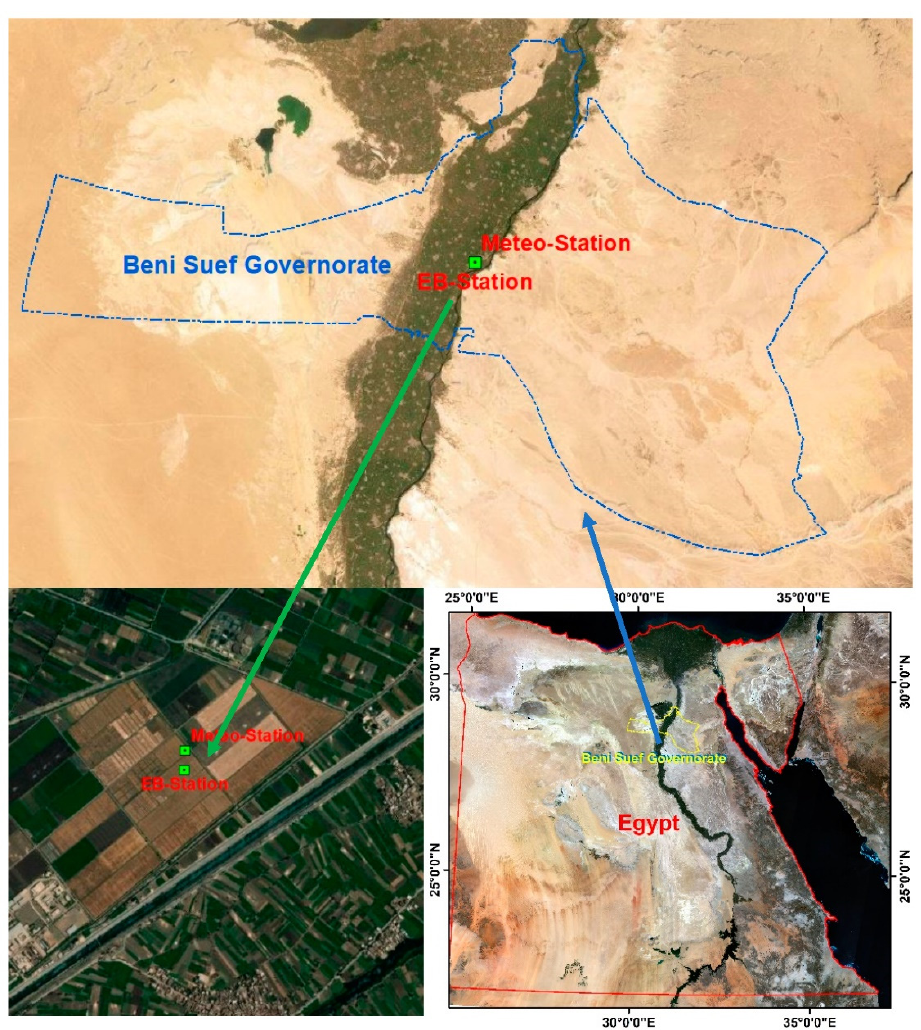
Figure 1. Location of the investigated study area in Sids Agricultural Research Station, Egypt.